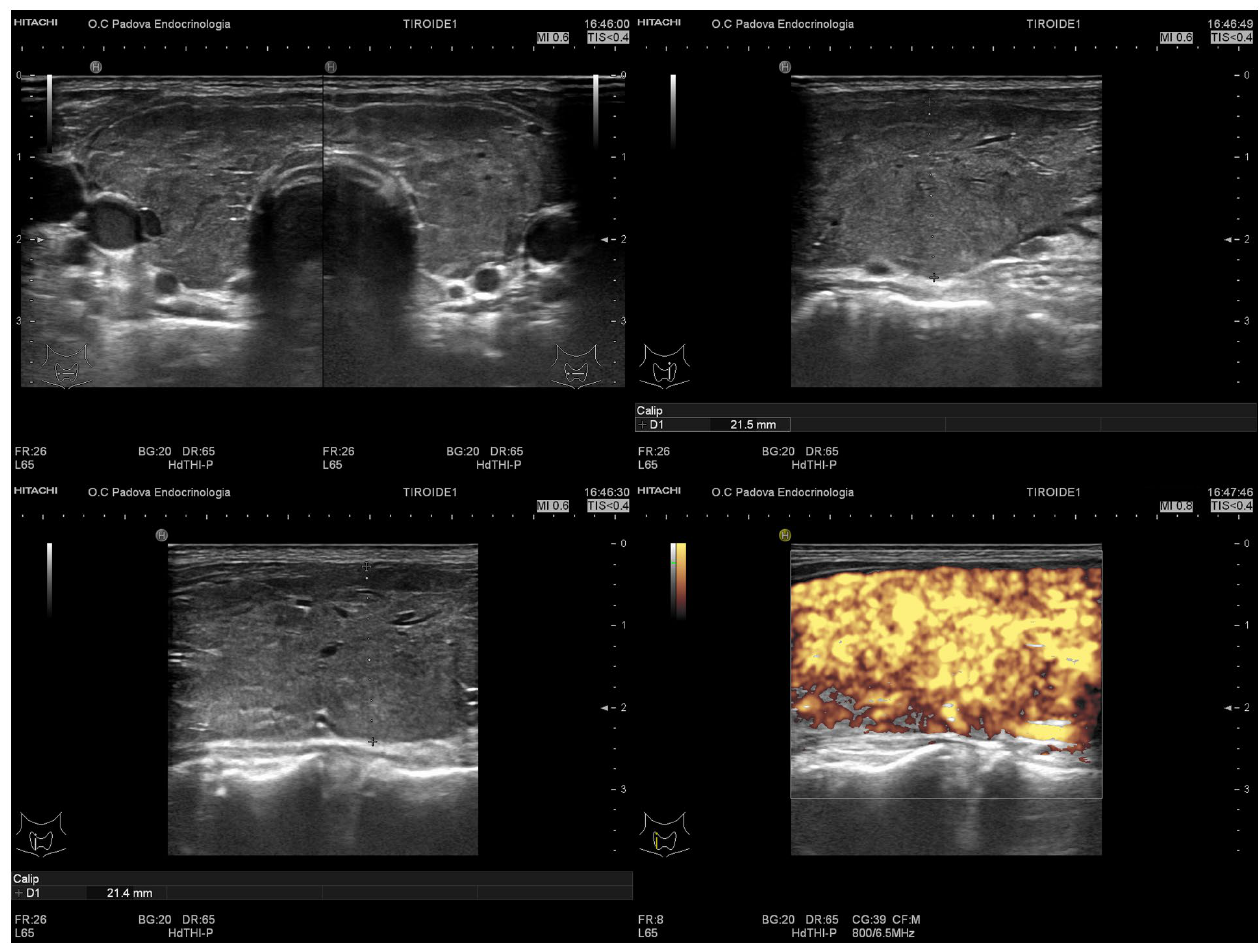
Figure 3. Thyroid ultrasound of Case 2.